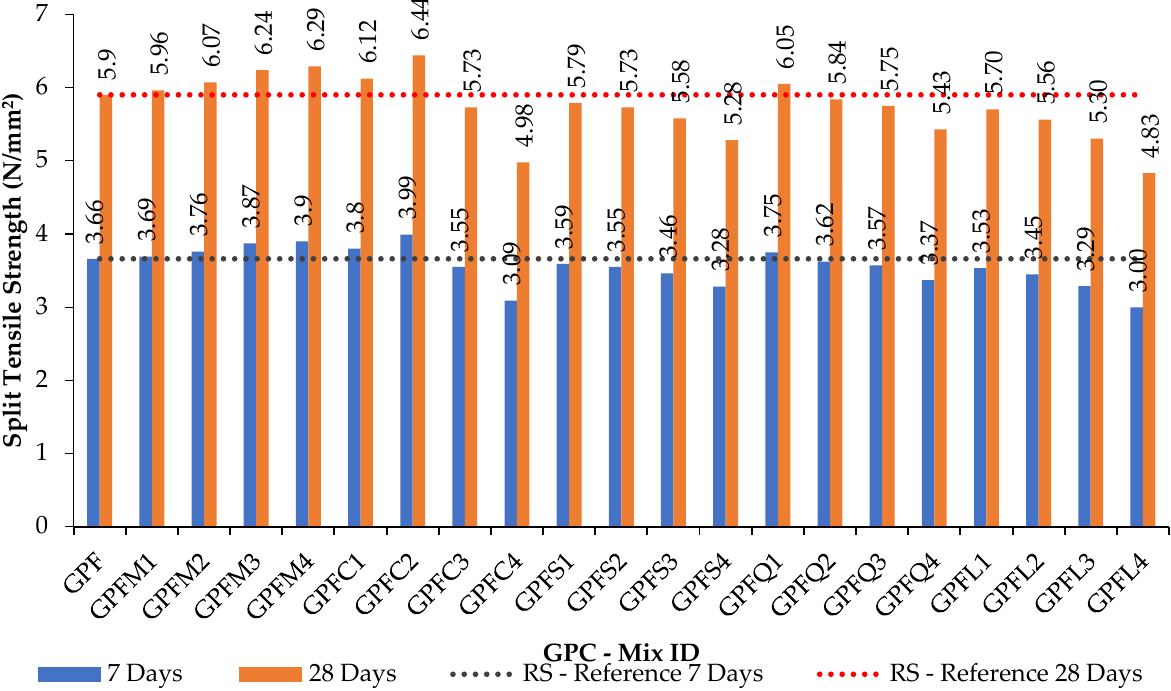
40 GPC with various fine aggregates.